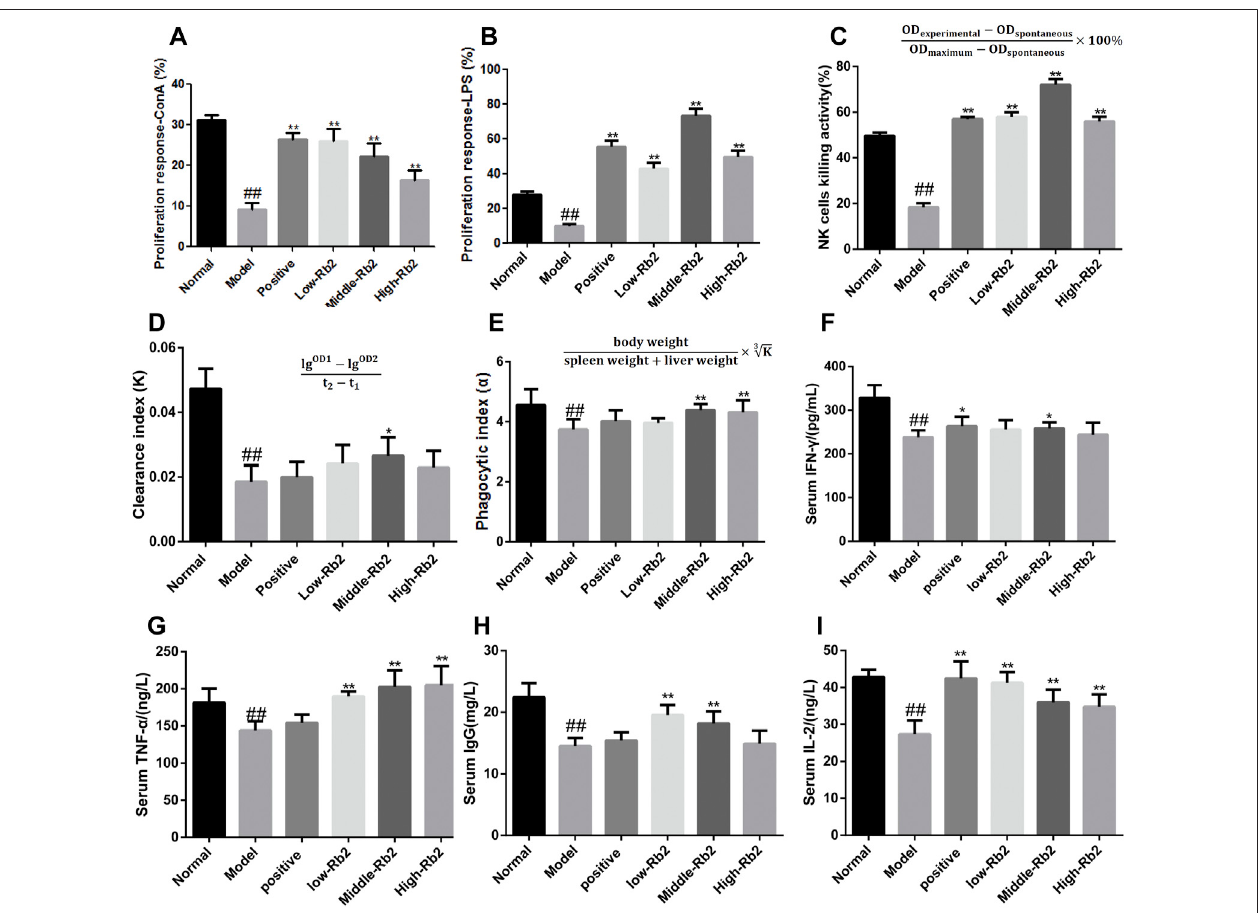
FIGURE 2 | Effect of ginsenoside Rb2 on ConA- and LPS- induced splenocyte proliferation, on NK cells activity, carbon clearance capacityin and the cytokines in CTX induced immunosuppressive mice. (A) , ConA-induced splenocyte proliferation; (B) , LPS-induced splenocyte proliferation; (C) , NK cells activity; (D,E) , carbon clearance capacityin; (F) , IFN- γ ; (G) , TNF- α ; (H) , IgG; (I) , IL-2. The data was expressed as mean ± S. D ( n = 20). ## p < 0.01, compared toNormal. * p < 0.05; ** p < 0.01, compared to